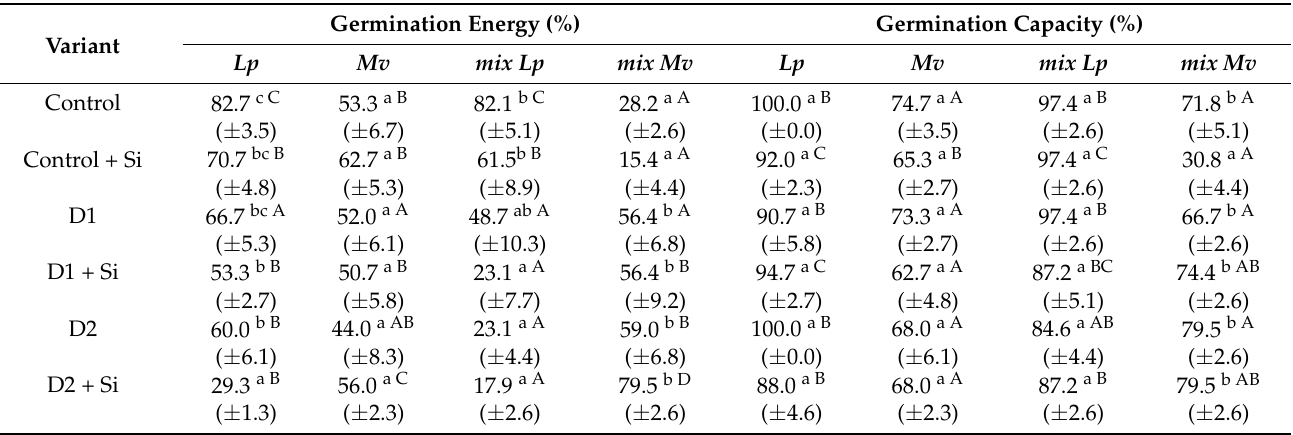
Table 1. Effects of different variants of drought conditions on germination energy and germination capacity of Lolium perenne ( Lp ) and Medicago x varia ( Mv